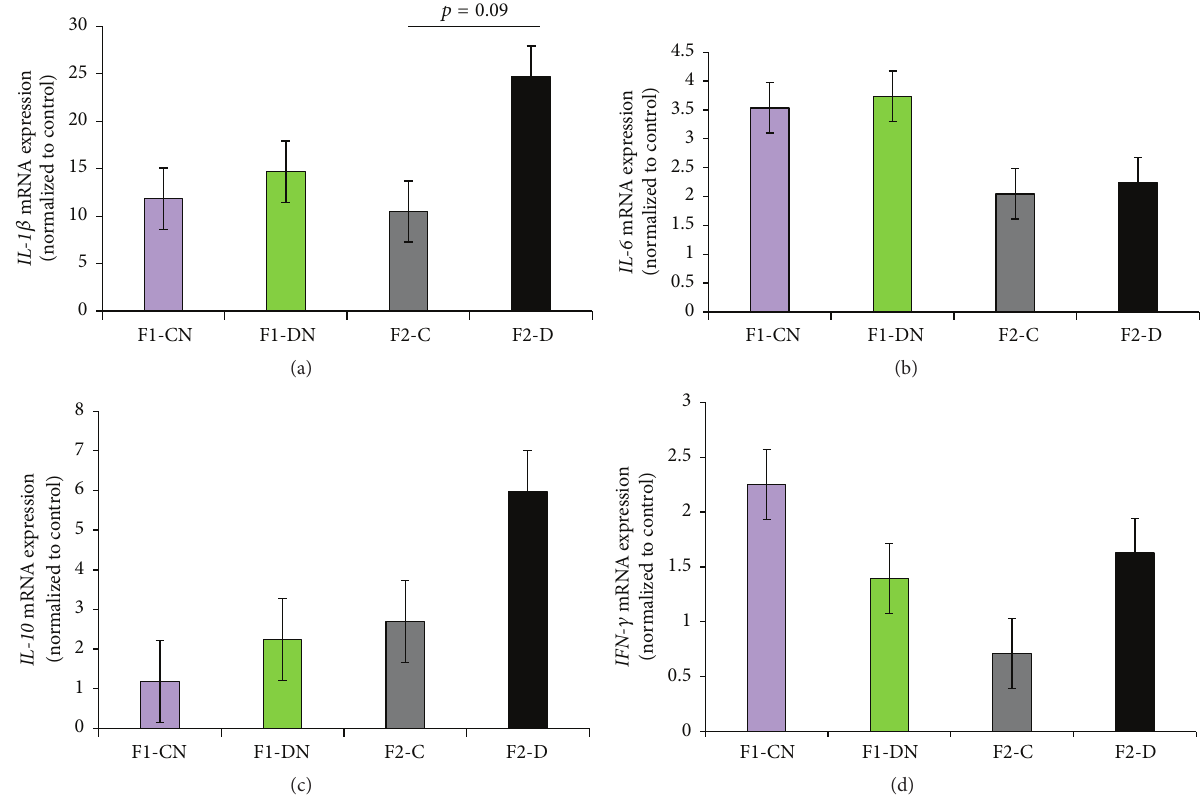
Figure 8: Inflammatory cytokines in perirenal adipose tissue. (a) IL-1 𝛽 expression was identified using real-time PCR. (b) IL-6 expression was identified using real-time PCR. (c) IL-10 expression was identified using real-time PCR. (d) IFN- 𝛾 expression was identified using real-time PCR. Results are presented as the means ± SEM. 𝑁 = 4